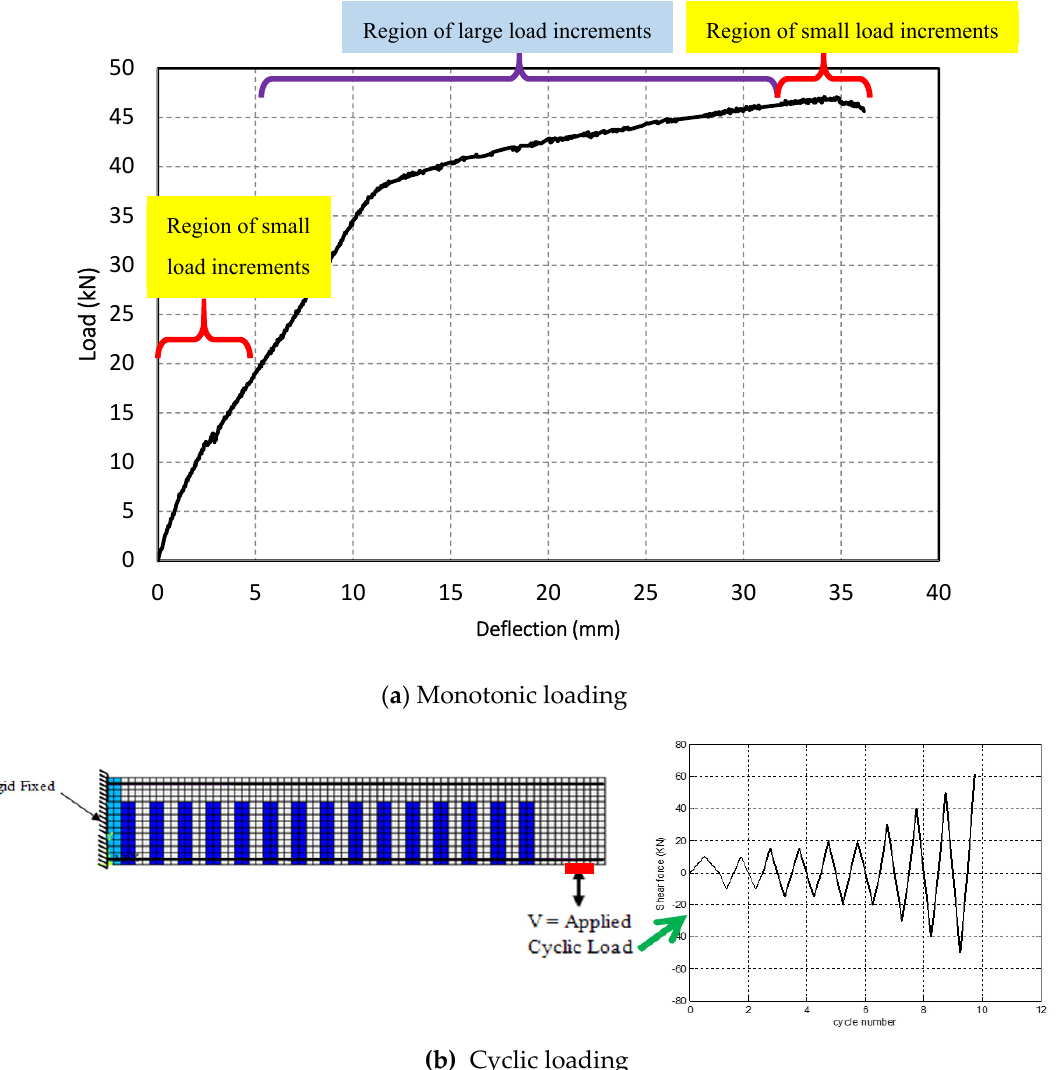
Figure 4. Consideration for applied loading in ANSYS and ABAQUS: ( a ) Monotonic loading; ( b ) Cyclic